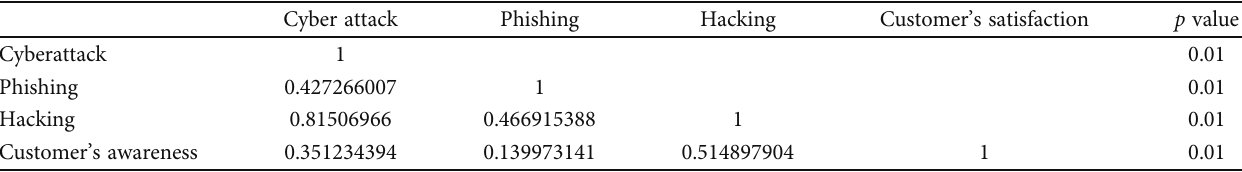
Table 4: Correlation analysis of the variables.